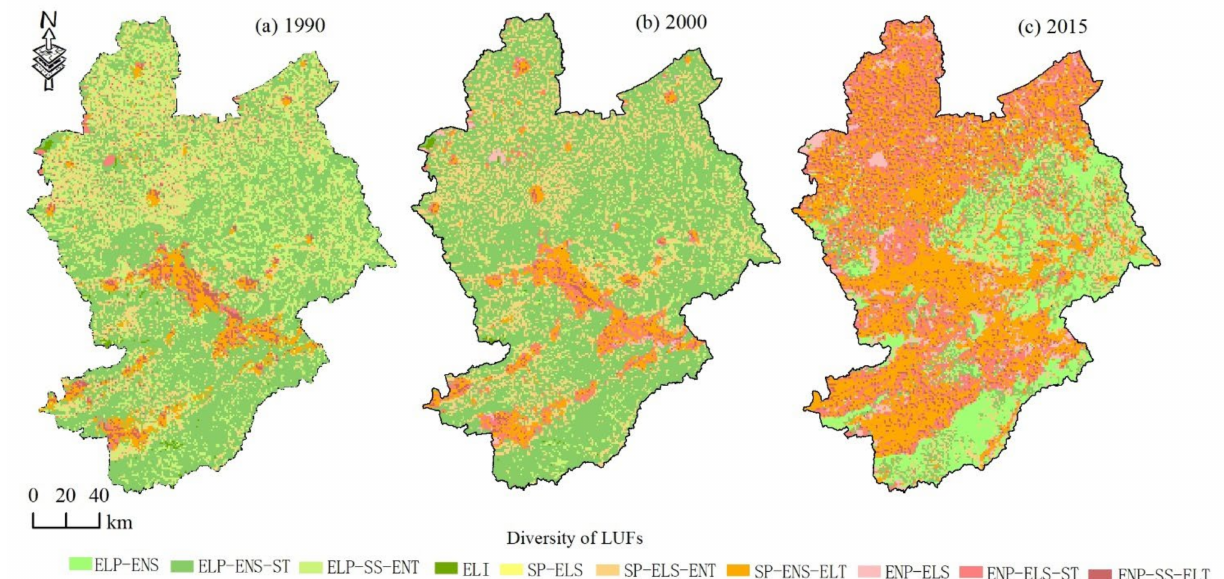
Figure 6. Spatial evolution of the diversity of LUFs at grid scale in Zhangjiakou City in